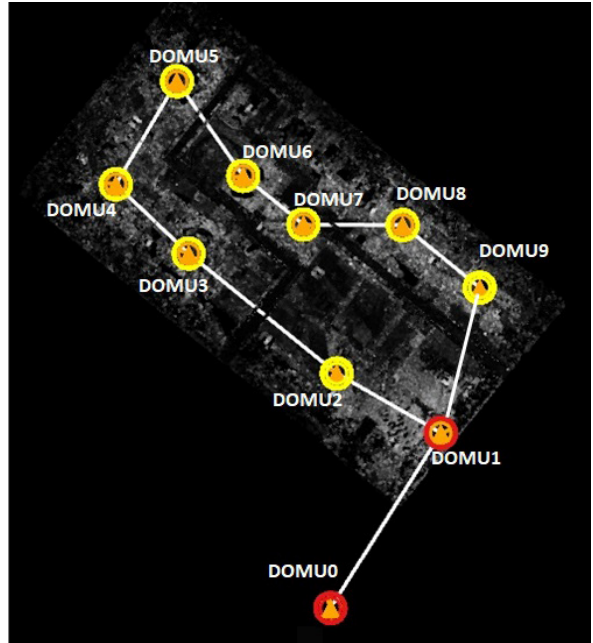
Figure 5. Traverse path of the scan points